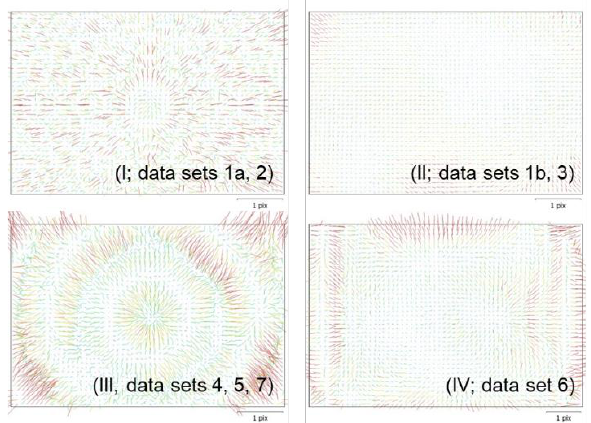
Figure 1. Typical residual patterns with systematics for data sets processed with B in Agisoft Metashape (pattern types with respect to data sets and their specifications are given in Table 1).